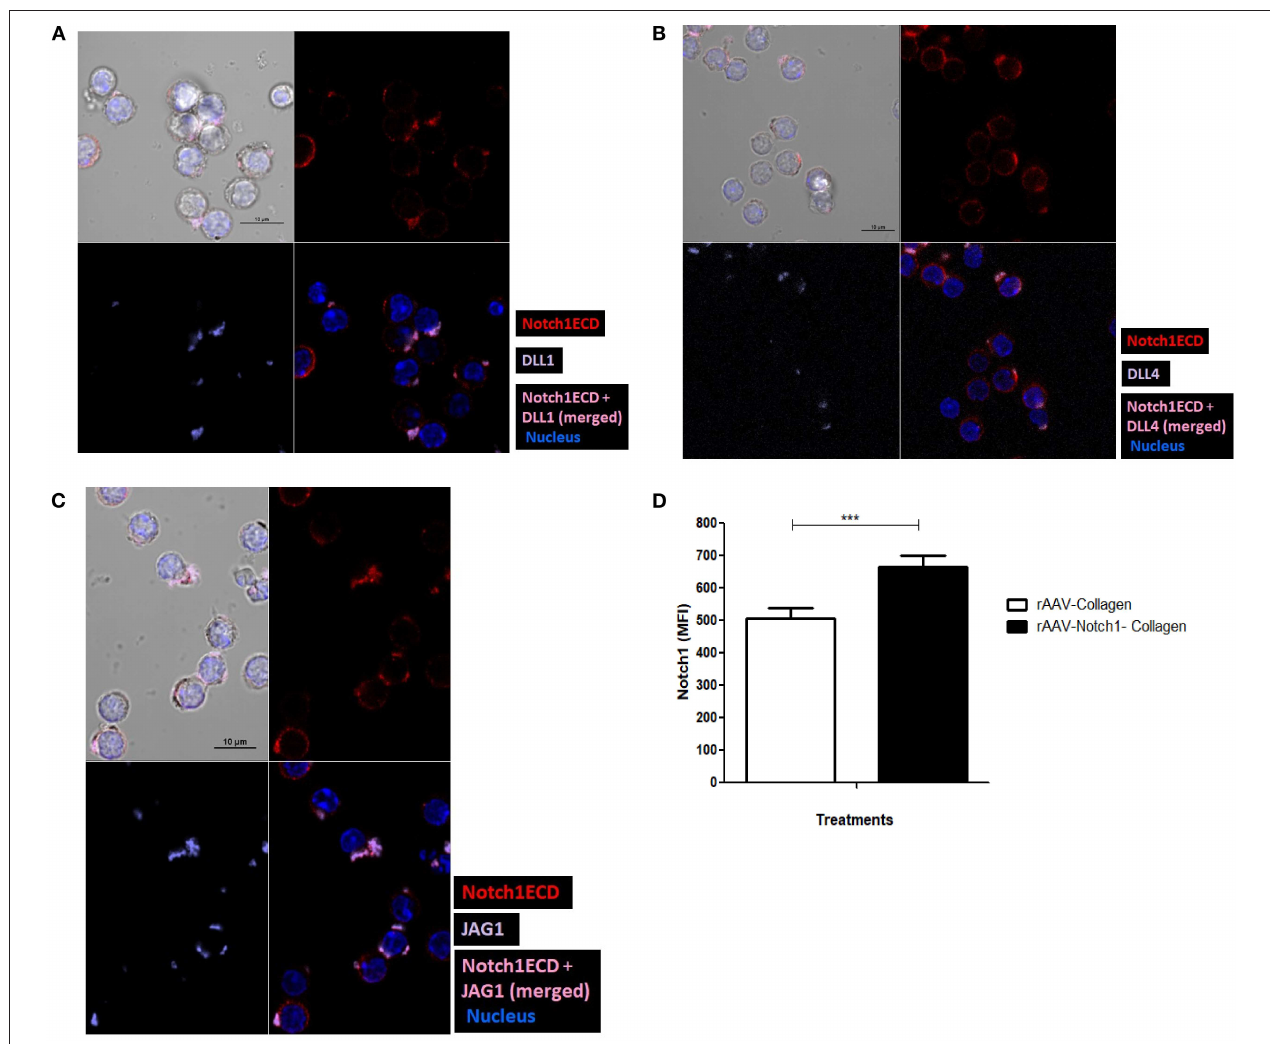
FIGURE 4 | Notch ligands expressed on CD4T cell cis -inhibit activated Notch upon colocalization. CD4T cells from C57BL/6 mice were treated with soluble anti-CD3 ε and anti-CD28 at 1 µ g/mL for 6h and surface stained for ligands (purple), Notch1ECD (red), and for nucleus cells were treated with DAPI. Colocalization of each of the ligands (A) DLL1, (B) DLL4, and (C) JAG1 with N1ECD at indicated time points. (D) Conditioned media containing decoy peptides collected from HEK293T cells transiently transfected with rAAV-collagen-Notch1ECD or rAAV-collagen. CD4T cells activated with 1 µ g/mL of each of soluble anti-CD3 ε and anti-CD28 in the presence of indicated amount of the concentrated conditioned media for 24h. Bar graphs MFI of N1ICD for each treatment. Data represent three independent experiments. The analysis was done by gating on live cells as determined by absence of zombie staining. Data represent mean ± SEM. *** p <